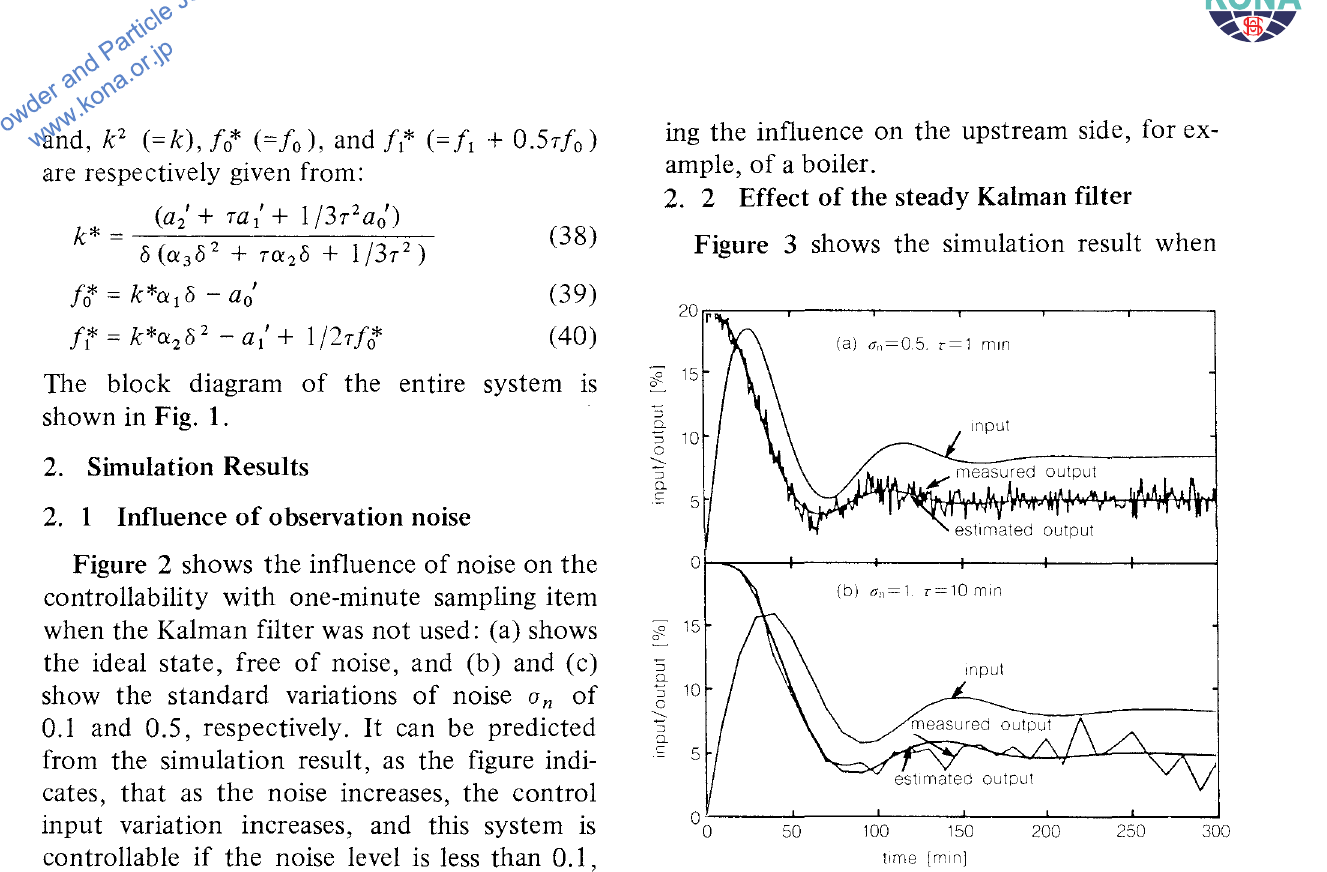
Fig. 3 Simulation result using Kalman Filter